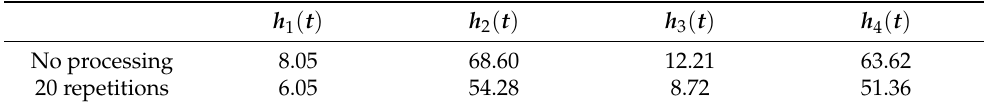
Table 6. Noise variance estimates on the h k ( t ) in the absence of processing and averaging the estimates over 20 repetitions; case of the higher SNR value (31